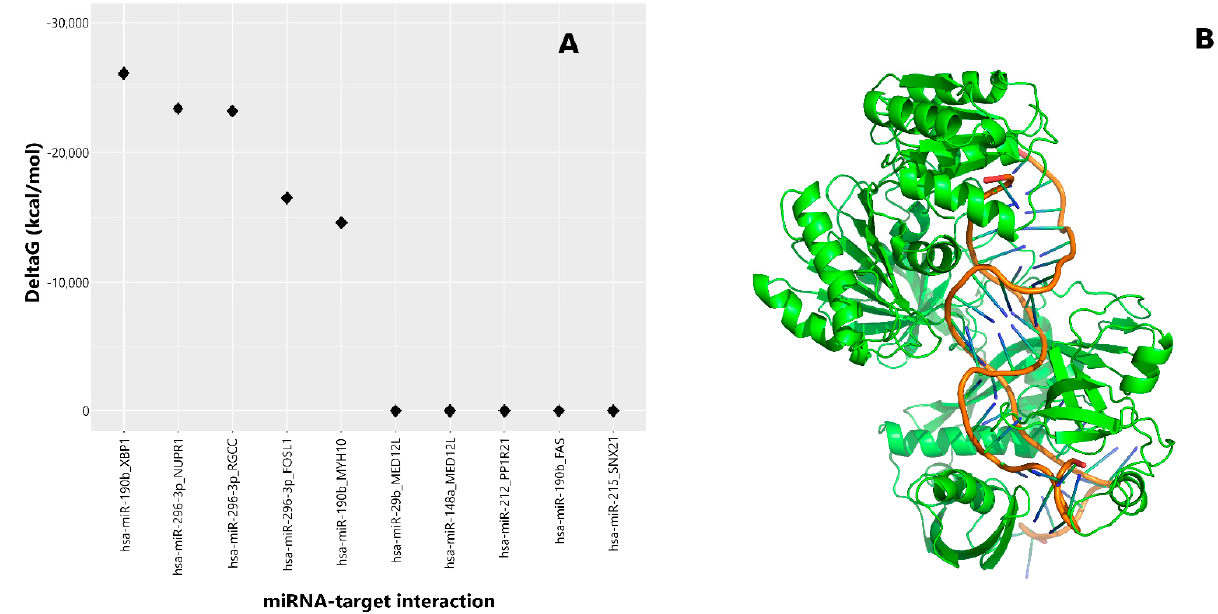
Figure 1. In silico analysis for the identification of favorable miRNA–mRNA target complexes induced in HeLa cells treated with γ T3: ( A ) Gibbs free energy decrease was estimated using MiREN software, testing for the 10 most favorable predicted miRNA–mRNA target pairs. The best complex was found in the hsa-miR-190b–Xbp1 pair. ( B ) Tridimensional model of the ternary complex formed by miR-190b, Xbp1 mRNA, and the T.hermus thermophilus AGO protein (PDB code: 3F73), which is considered an appropriate structural model representative of the eukaryotic members of AGO proteins.